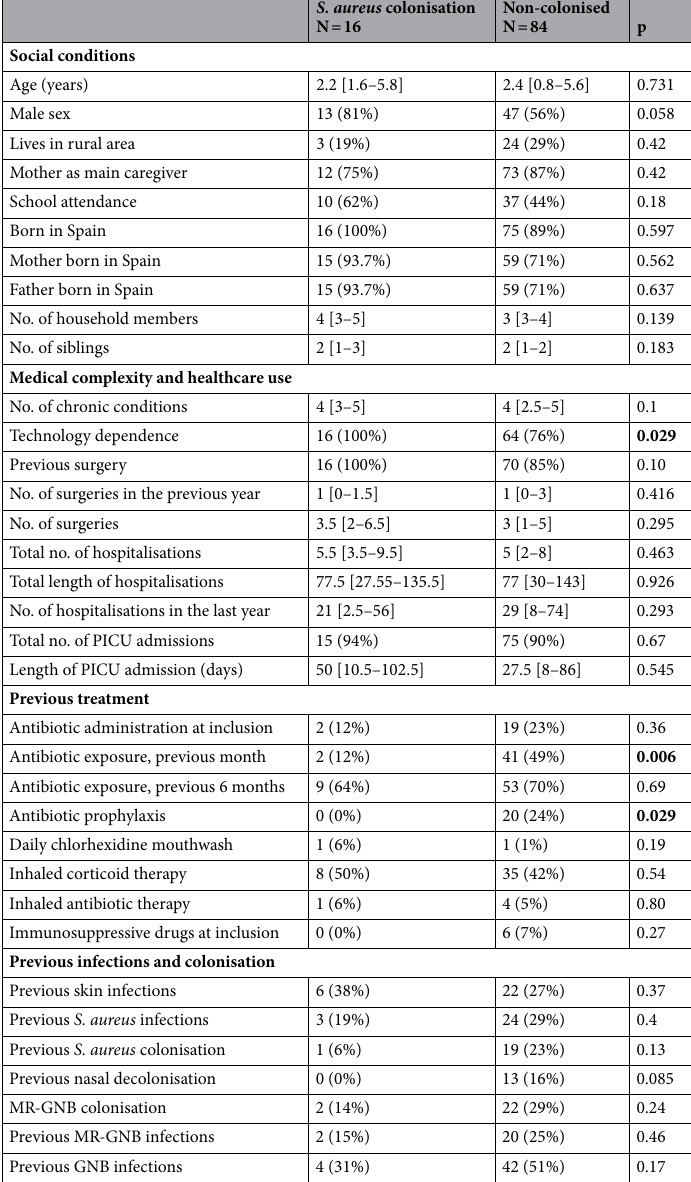
Table 1. Factors associated with S. aureus nasal colonisation in children with chronic conditions. PICU, paediatric intensive care unit; MR-GNB, multidrug-resistant Gram-negative bacilli. Significant values are given in